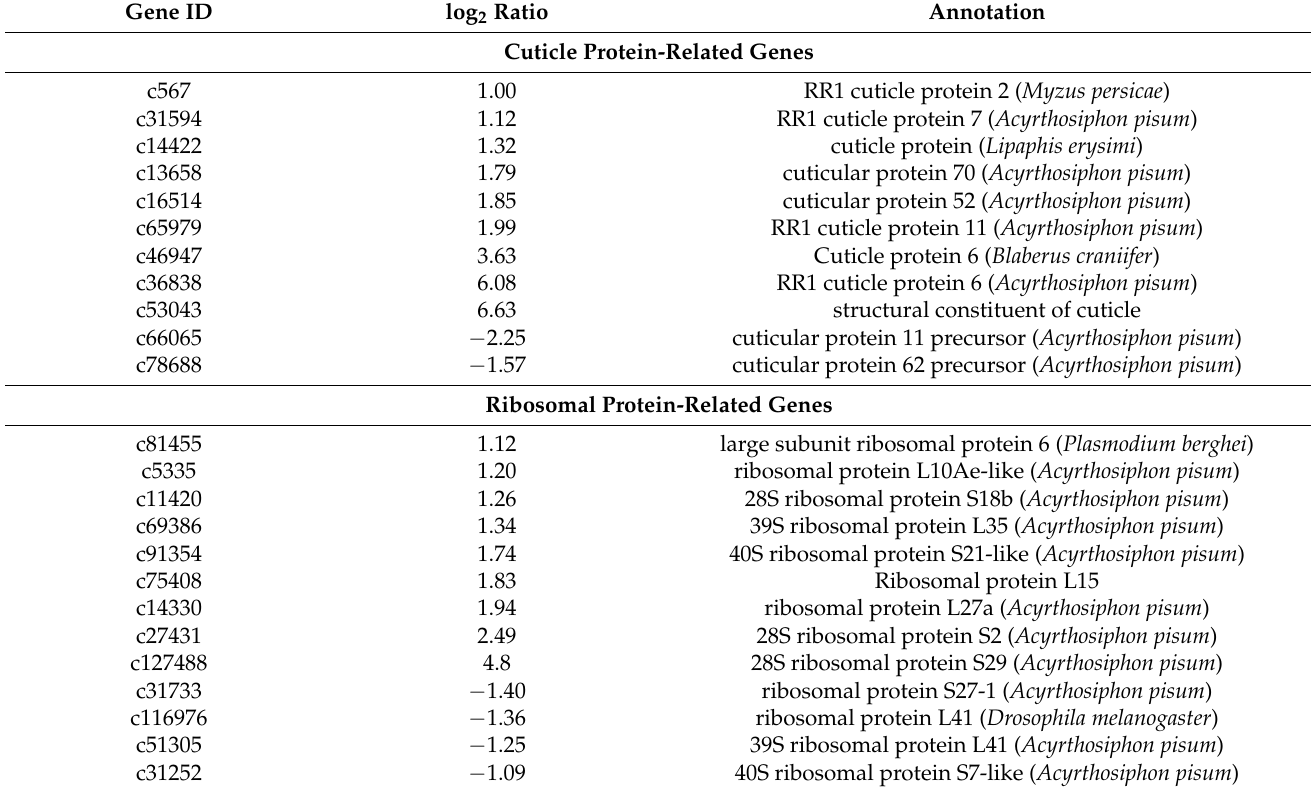
Table 2. DEGs that are related to genes encoding cuticle proteins and ribosomal